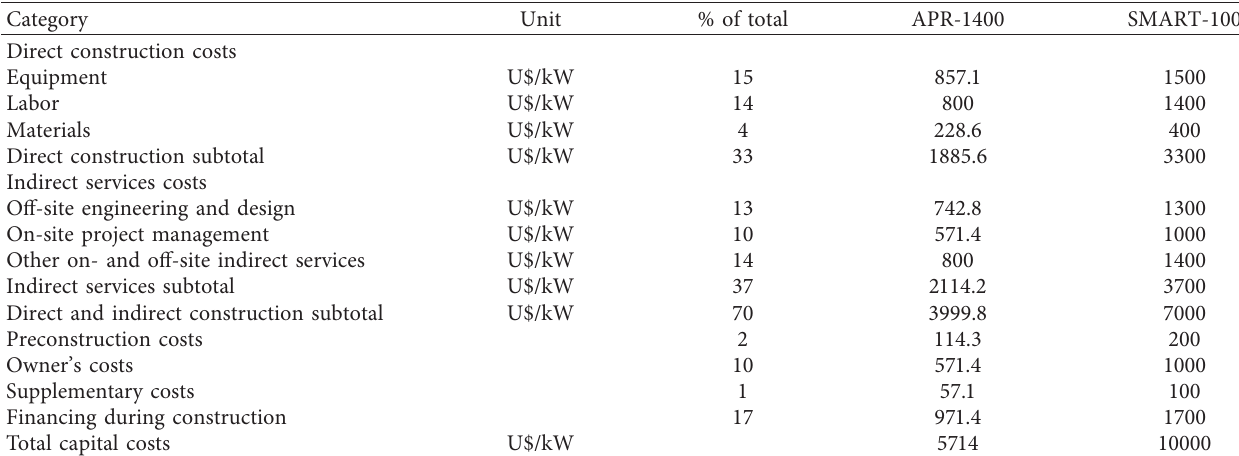
Table 7: Capital cost category estimate for the candidate NPPs assumed in this study